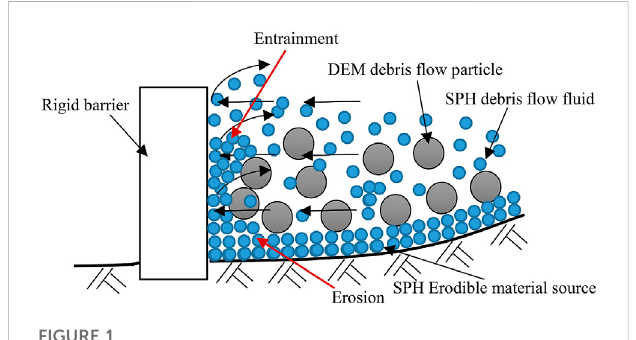
FIGURE 1 Schematic diagram of the erosion-entrainment